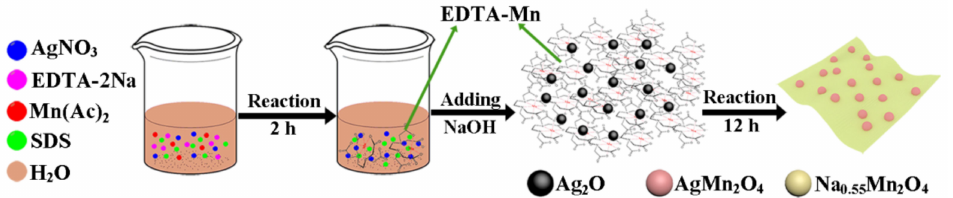
Figure 1. Schematic illustration of the formation mechanism of AgMn 2 O 4 @Na 0.55 Mn 2 O 4